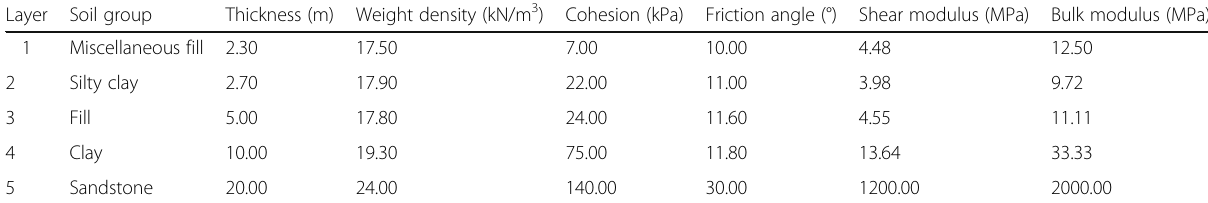
Table 4 Soil Parameters applied in numerical model Layer Soil group